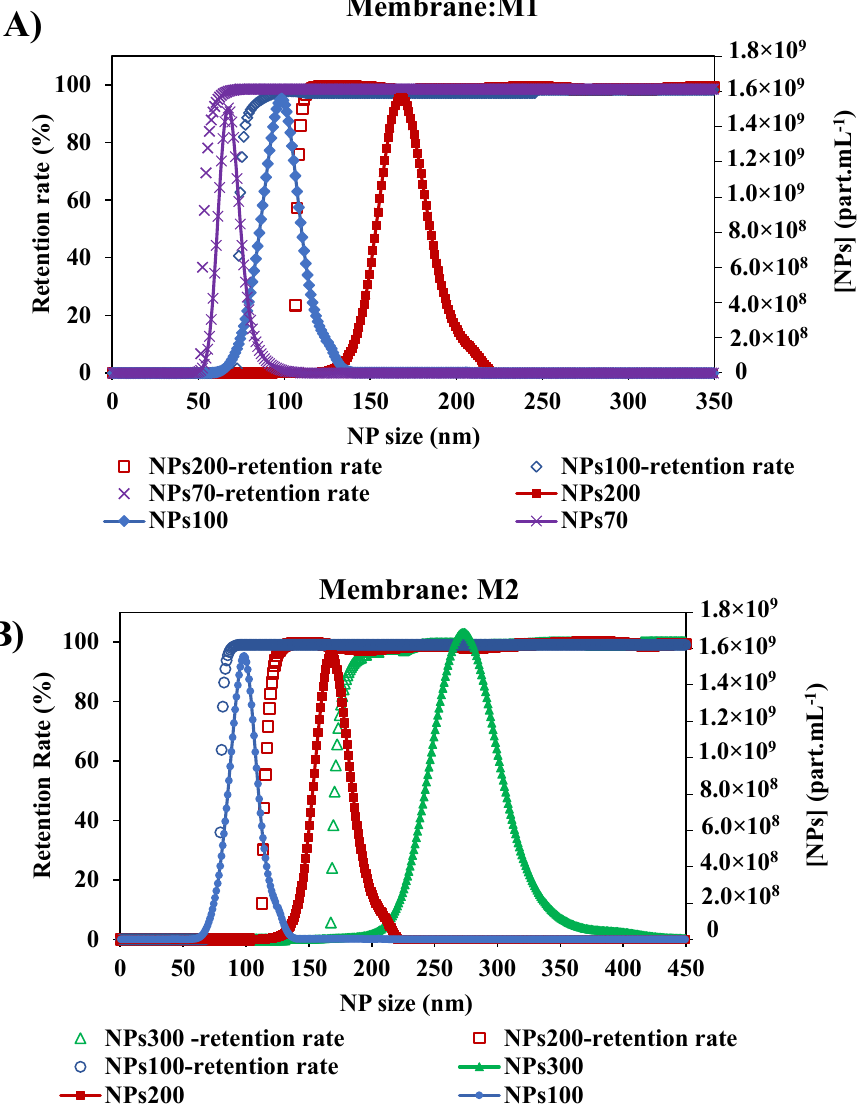
Figure 7. Retention rates of the di ff erent size of NPs with two membranes: ( A ) Membrane M1 with the initial suspension solution of NPs 200, NPs 100 and NPs 70 nm, and ( B ) Membrane M2 with the initial suspension solution of NPs 300, NPs200 and NPs100 nm. [TMP ~ 0.5 bar, room temperature].